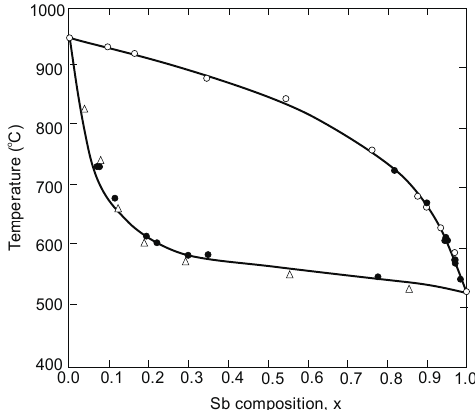
Figure 1. Pseudobinary phase diagram for the InAs-InSb systems [1].